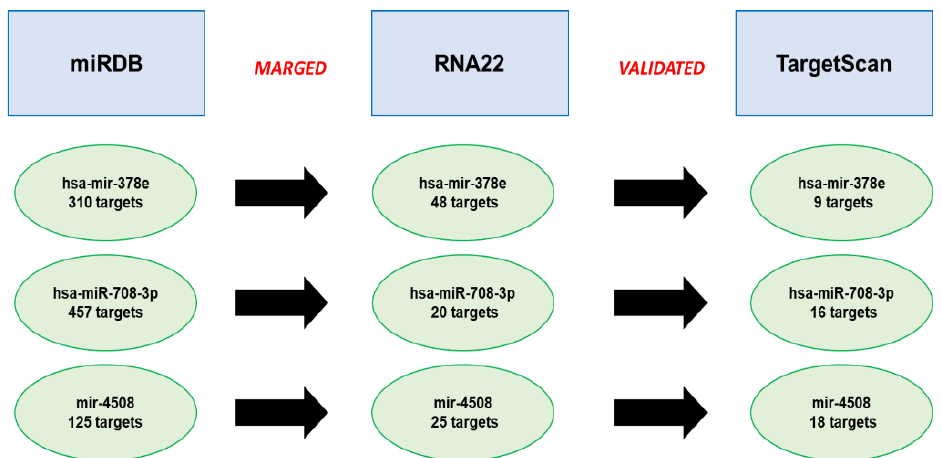
Figure 5. Predicted targets for preeclampsia miRNAs. The overlapping target genes were predicted thanks to the online analysis tools: miRDB, RNA22 and TargetScan; in miRDB using 60–100 as a range for the Target Score; in the RNA22 version 2.0 using the following filters: base pair min value = 12, folding energy max value (Kcal/mol) = − 12 and p -value < 0.05. In TargetScan 8.0, take the total context ++ score as the prediction truthfulness value.